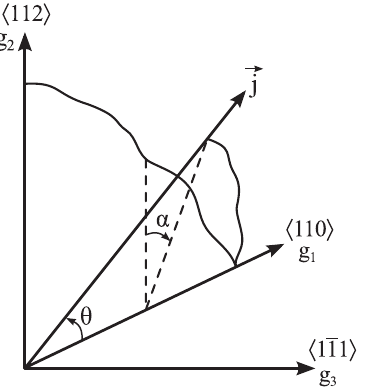
FIG. 7. The particle motion in the system defined by the crystallographic axes of the